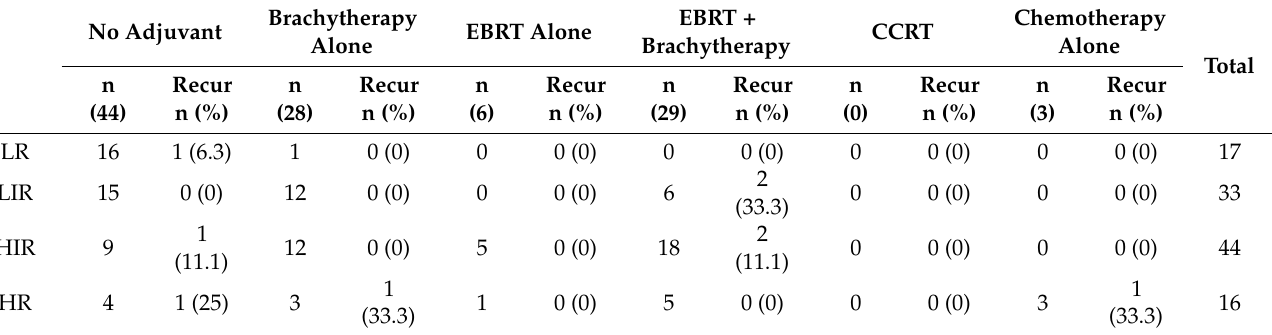
Table 4. Comparison of adjuvant treatments, and recurrences by the Gynaecology Oncology Group (GOG) for postmenopausal group among women with stage 1 endometrial cancer in Hospital Melaka from 2001–2020.